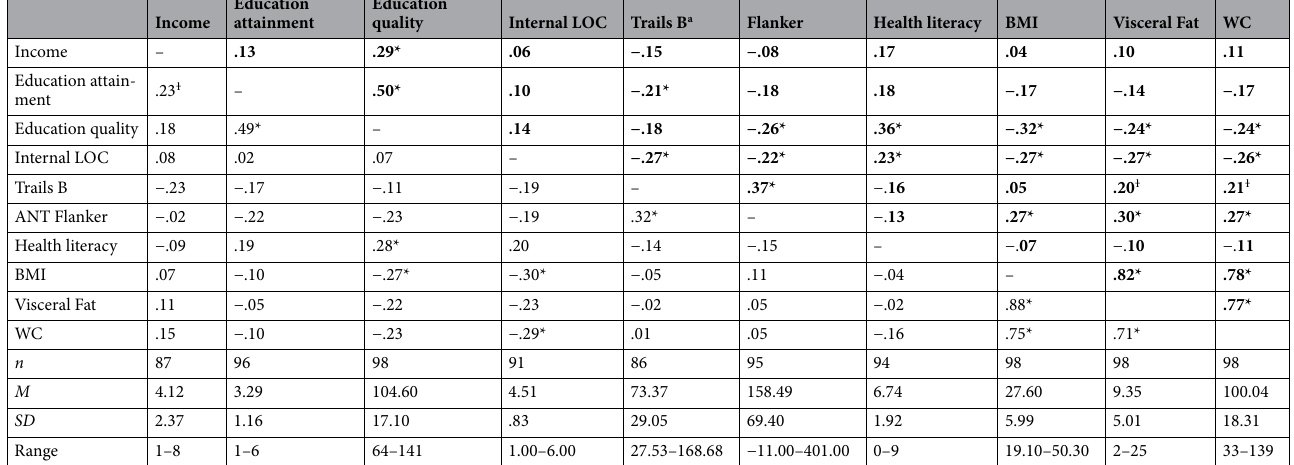
Table 1. Correlations among primary study variables and descriptive statistics for each variable. Bolded values above the diagonal are bivariate correlations and those below the diagonal are partial correlations adjusted for age, sex and ethnoracial category. WC = waist circumference. ƚ p < .06, * p < .05, a = one outlier windsorized for analyses.